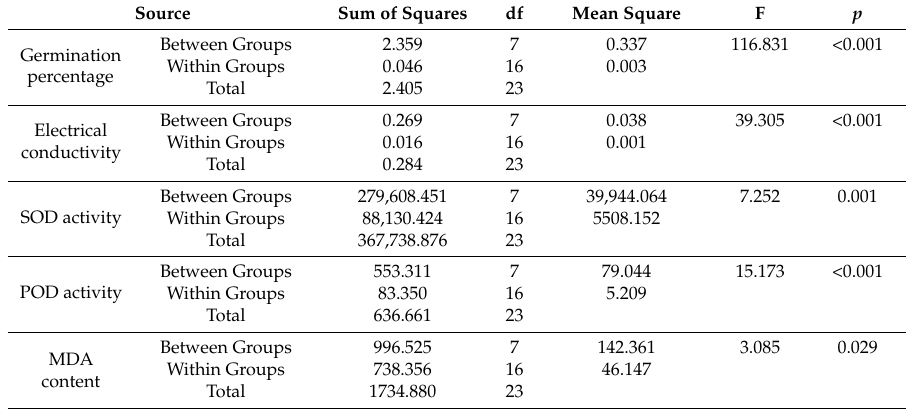
Figure 3. Changes of germination in G. biloba seeds during desiccation. Data are means of three replicates ± SD, and bars labeled with the same lower-case letter do not differ significantly at the 0.05 probability level. Table 1. Results of a one-way ANOVA for physiological changes in G. biloba seed during